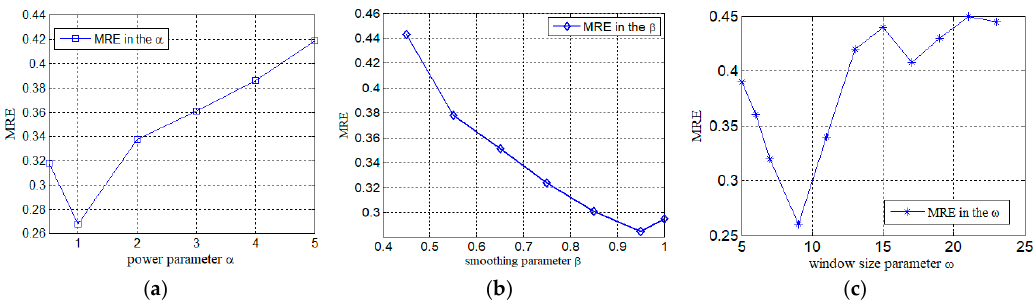
Figure 11. Impact of different parameters for DNN-MVL. ( a ) Power parameter α ; ( b ) smoothing parameter β ; ( c ) window size ω .